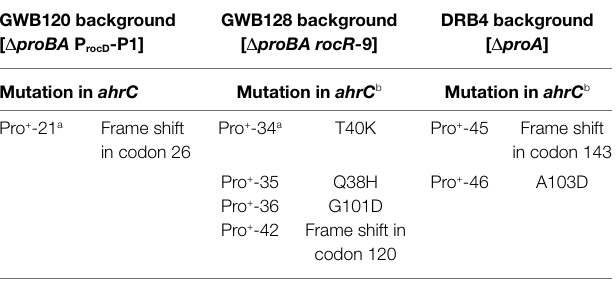
TABLE 2 | Suppressor mutations targeting the ahrC regulatory gene.